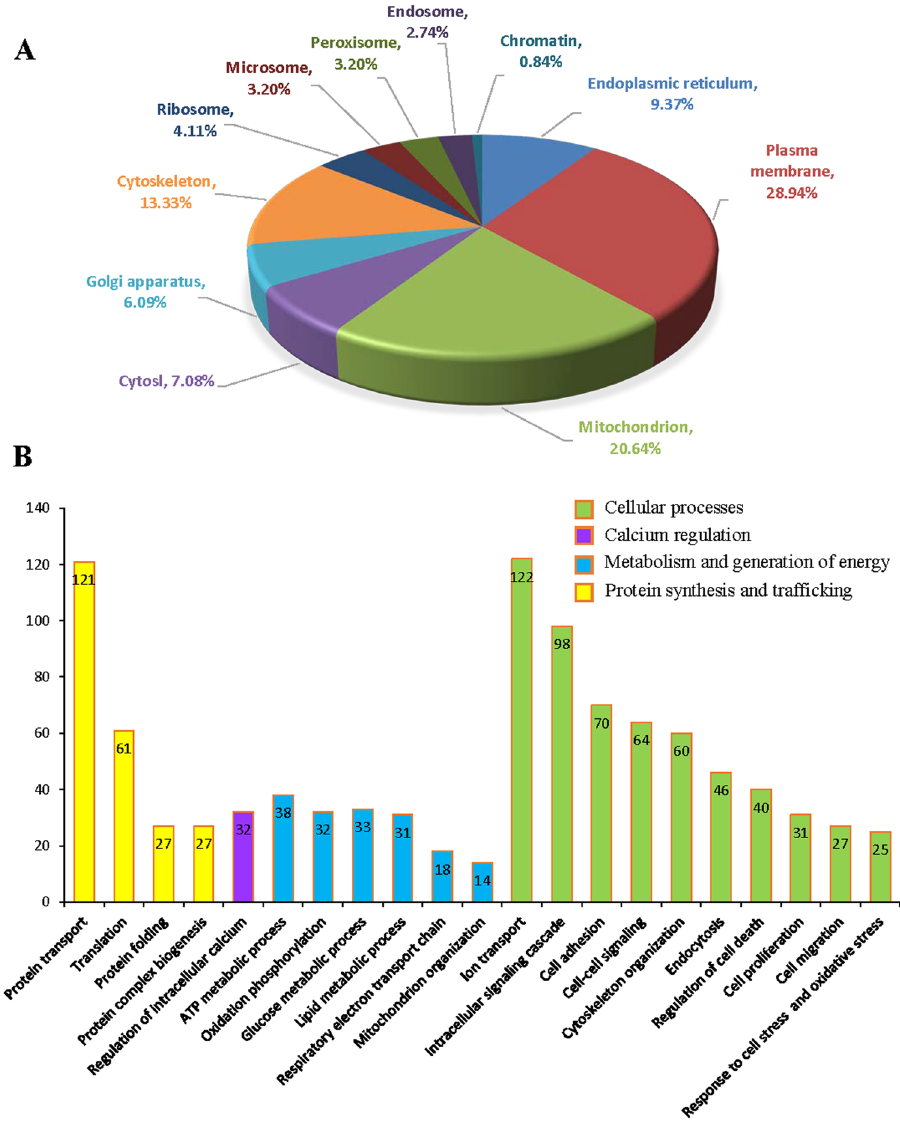
Figure 3. Localization and biological relevance of the mouse brain MAM proteins identified by proteomics. ( A ) Organelle association for MAM proteins determined by annotation. ( B ) According to GO biological processes analysis, 4 major clusters cellular activities including 21 catalogues of biological processes are shown. Processes with a p value less than 0.01 were considered